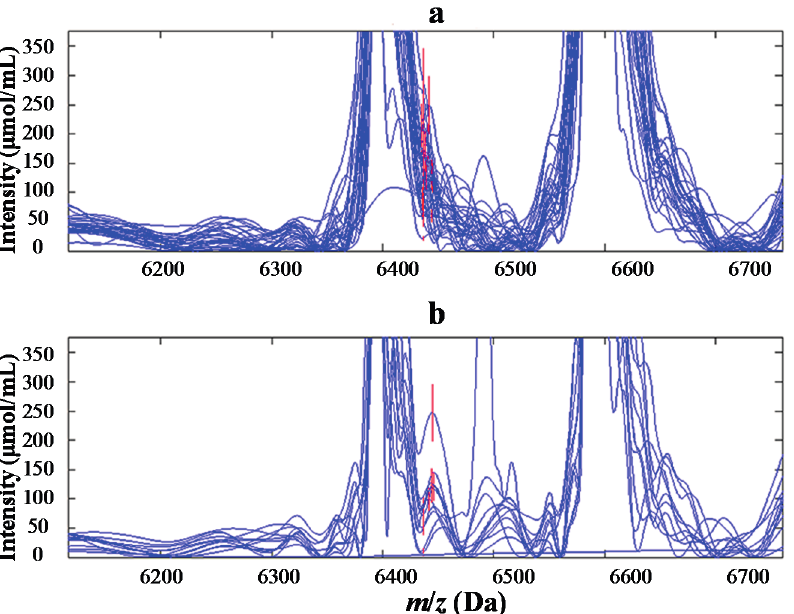
Figure 1. Mass spectrograph and electrophoretogram of protein with m / z of 6438 Da (the red line area). ( a ) the normal control group; and ( b ) the Wilms’ tumor group.